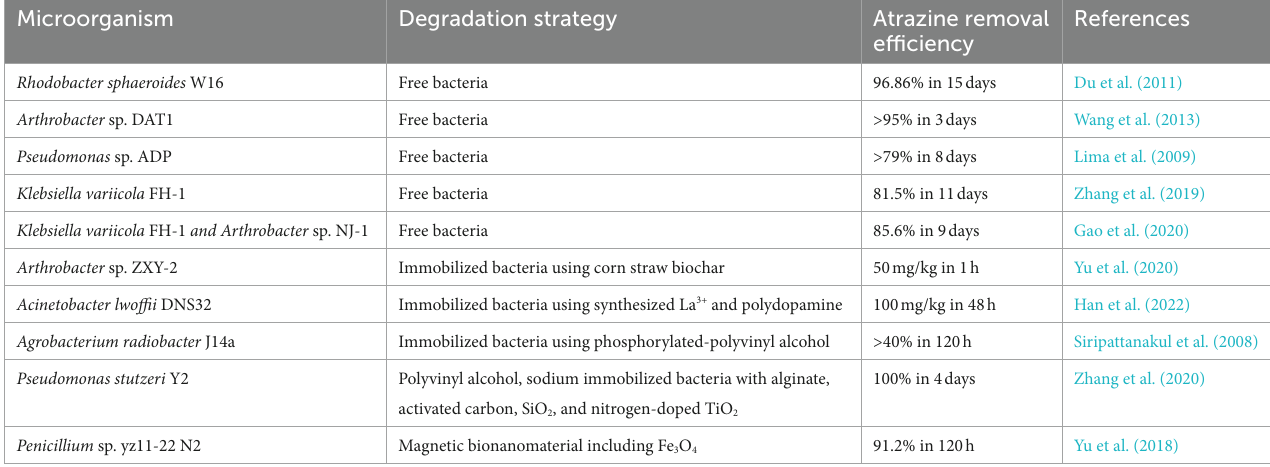
TABLE 1 Atrazine-degrading microorganisms with high degradation